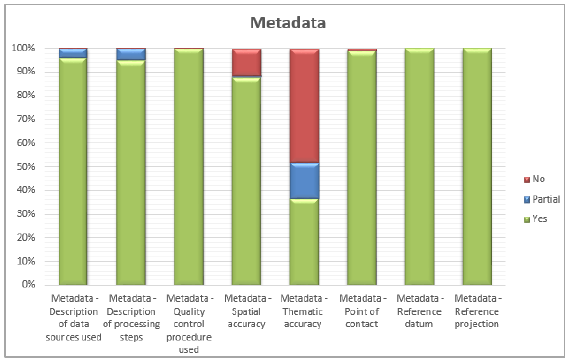
Figure 6. Presence of information regarding metadata from 2013 to